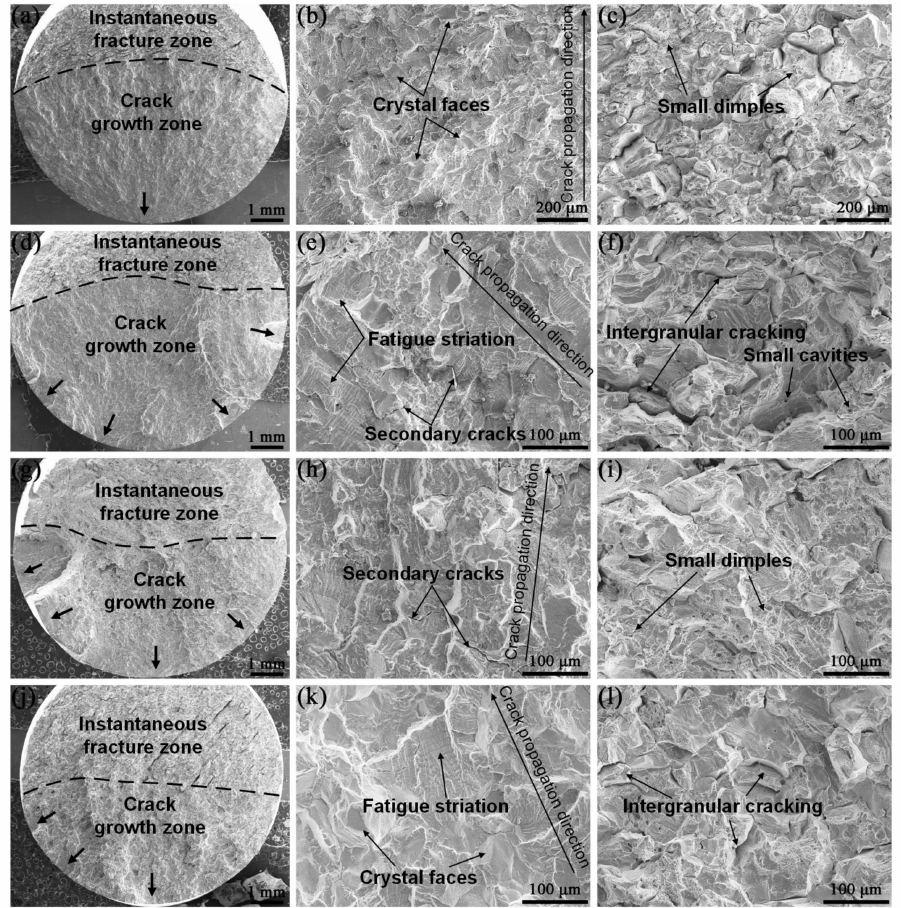
. ε = 2 × 10 − 3 s − 1 ; . ε = 3.2 × 10 − 4 s − 1 ; ( j – l ) with